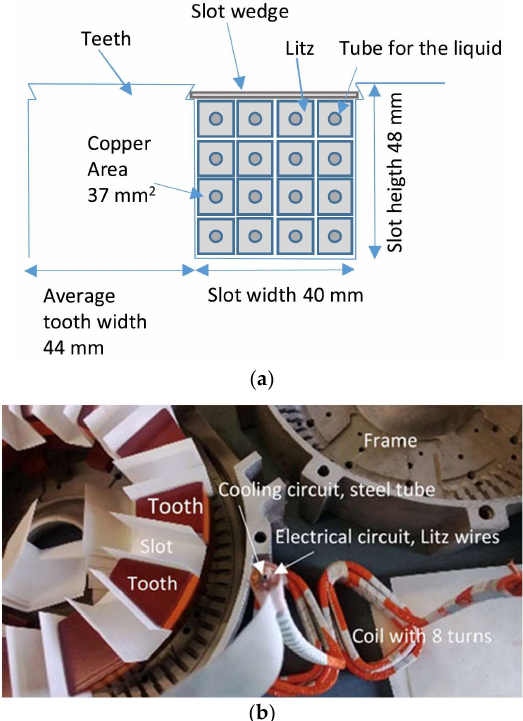
Figure 14. Configuration of an axial-flux permanent magnet machine [38]. ( a ) Slot configuration; ( b ) stator configuration. ( b ) stator configuration.